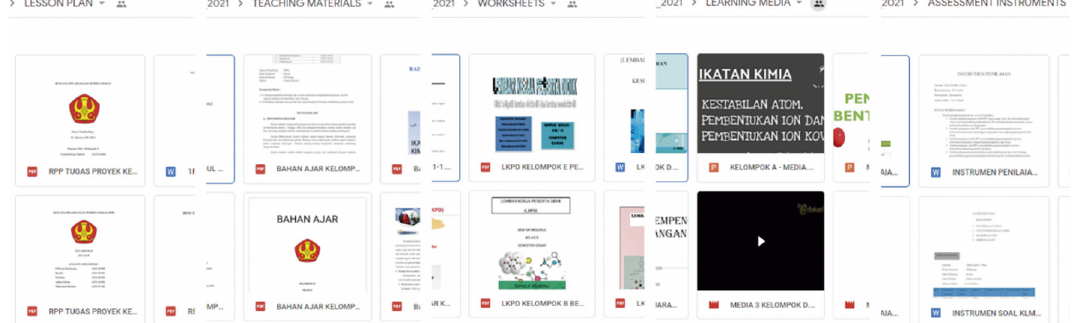
Figure 2. Results of projects done by students in groups for P3K Course